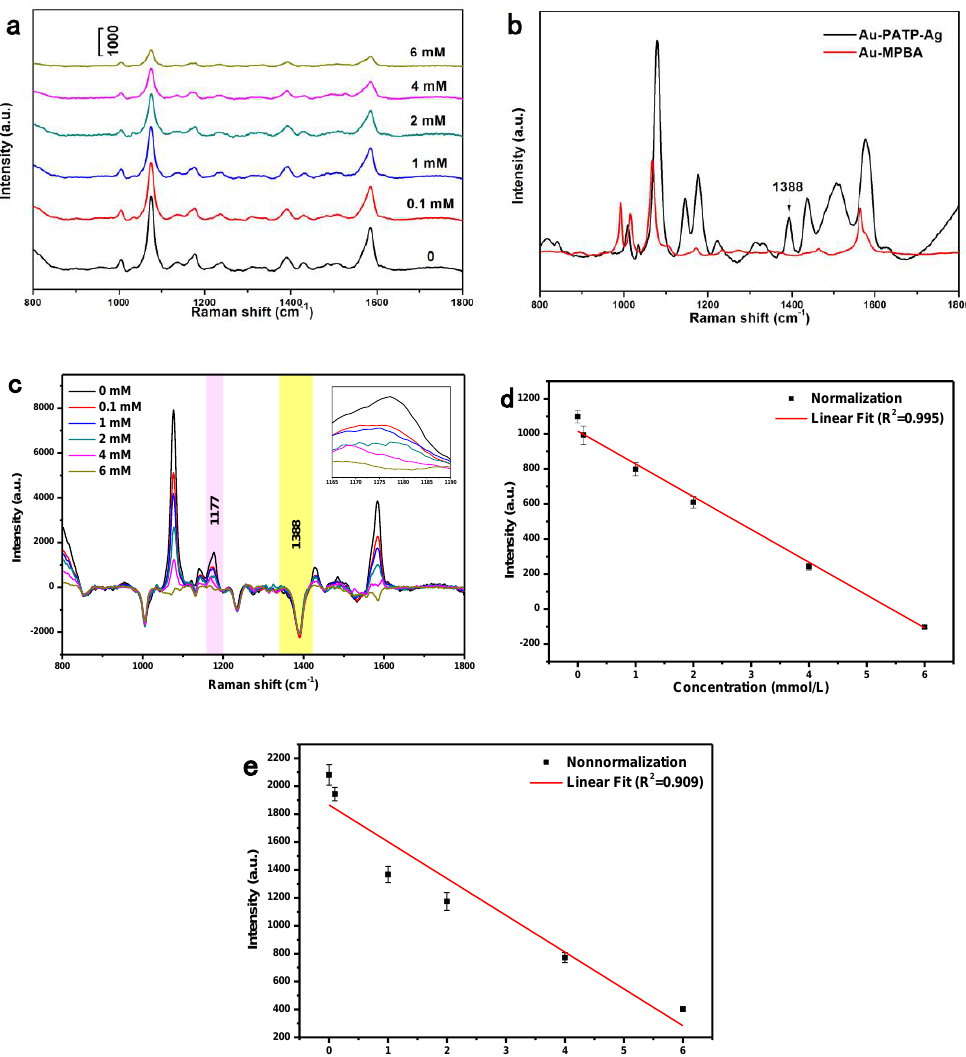
Figure 5. ( a ) Original SERS spectra recorded at different concentrations of glucose; ( b ) SERS spectra of 4-MPBA–modified Au NPs and Au@Ag NPs; ( c ) Normalized SERS spectra recorded at different concentrations of glucose, and the inset is the enlarged view of the peak of 1177 cm –1 ; ( d–e ) the working curves of the peak at 1177 cm –1 based on normalized SERS spectra and original SERS spectra.